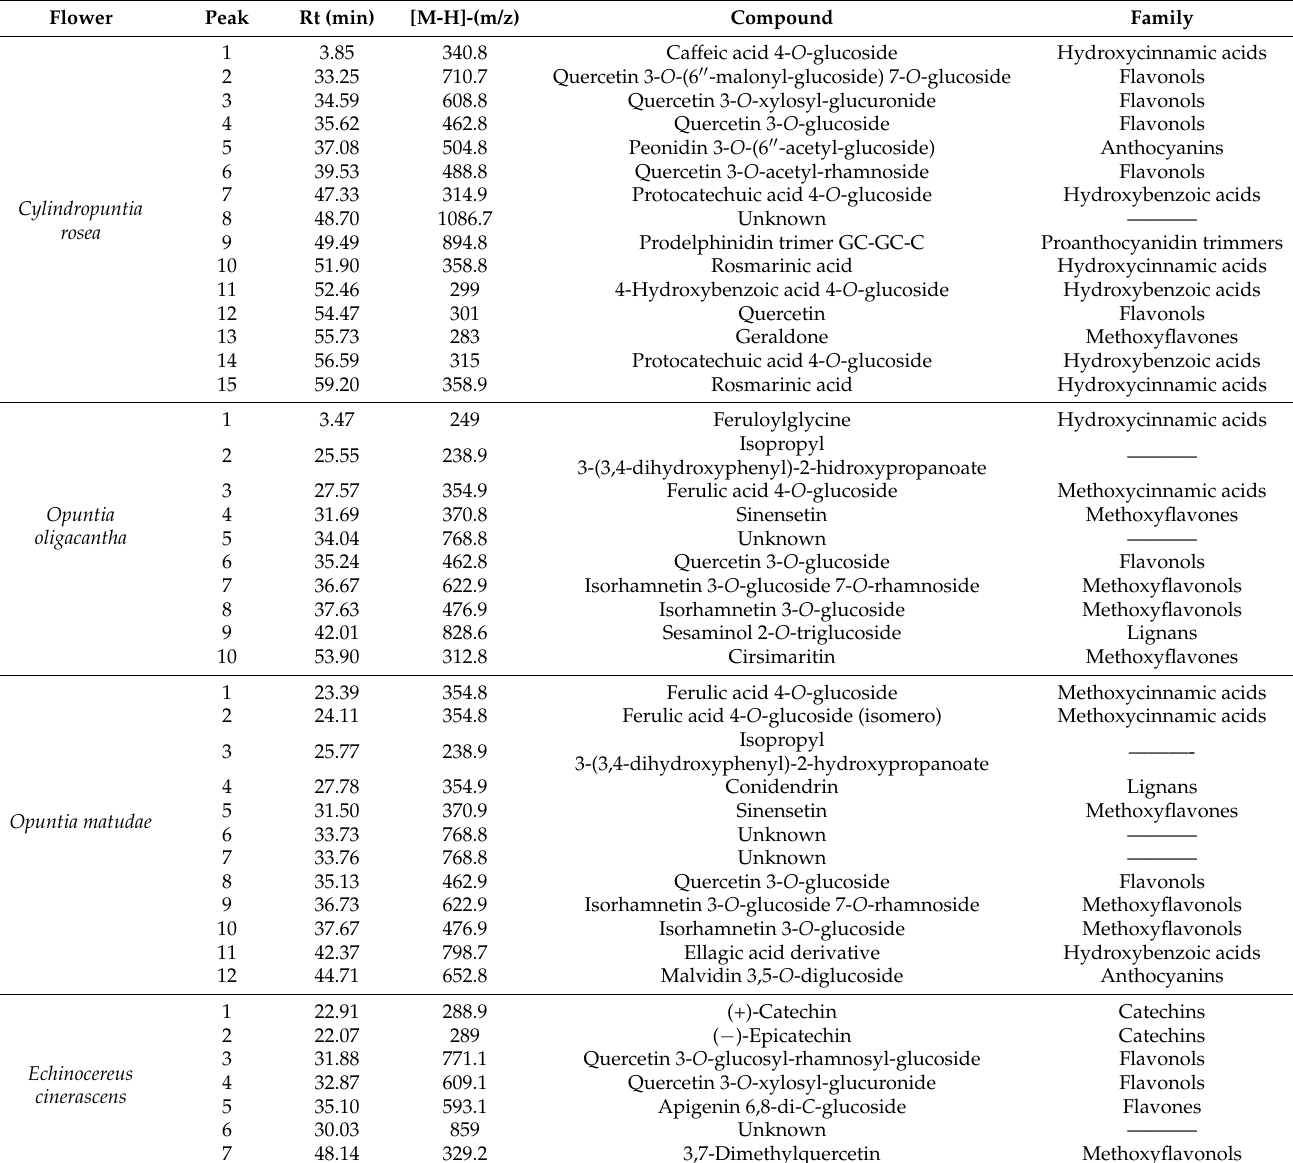
Card ó n ( Cylindropuntia rosea ), Xoconostle cv. Ulapa ( Opuntia oligacantha ), Xoconostle cv. Cuaresmeño rosado ( Opuntia matudae ), Pitaya ( Echinocereus cinerascens ). Rt = Retention time, [M-H]-(m/z) = mass-charge ratio. All experiments were performed in negative ionization mode, wavelength 280